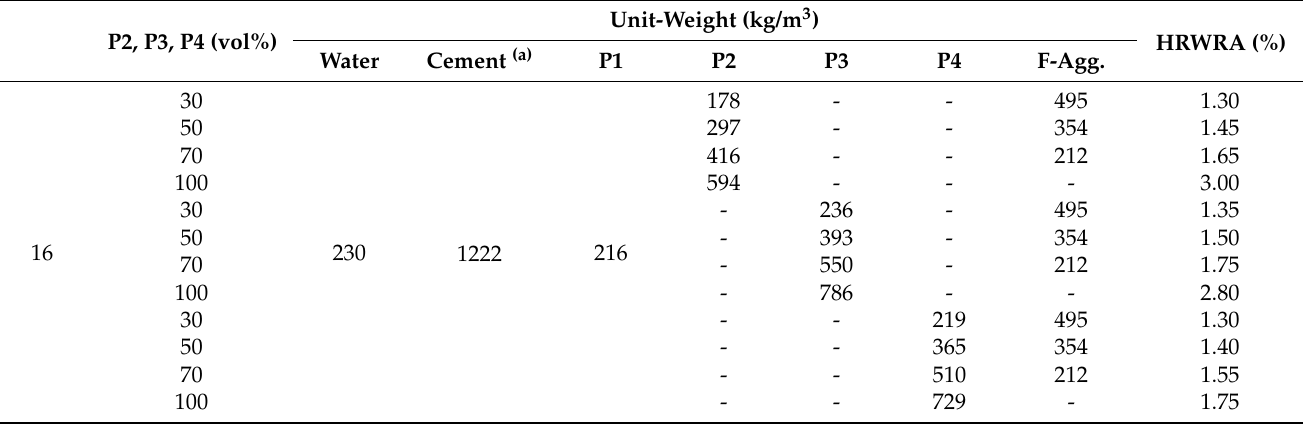
Table 7. Mixture proportions of base mortar (a test for fine aggregate replaced by powder material).